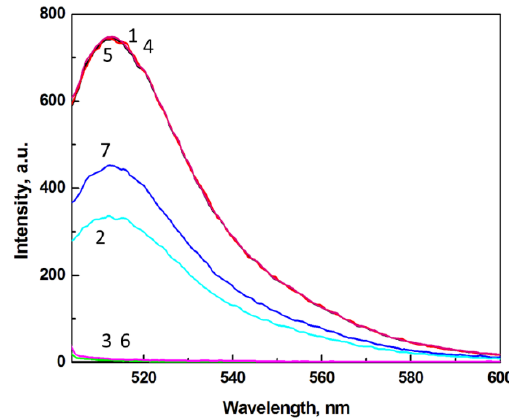
Figure 1. (A) Fluorescence emission spectra for: (1) FITC, (2) FITC + AuNP@Cit, (3) AuNP@Cit, (4) theoretical sum (1) + (3); (5) FITC + PD-L1, (6) PD-L1; (7) FITC + AuNP@Cit / PD-L1; solution: 50 mM